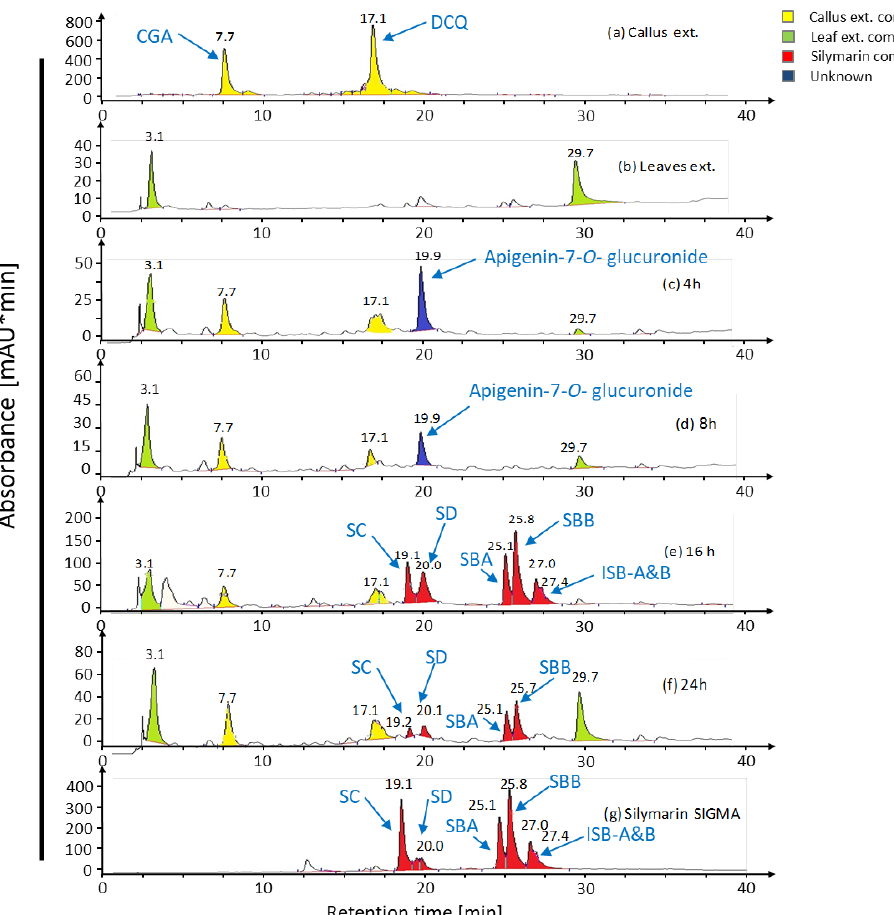
Figure 2. Chromatographic analysis of the products obtained from bioconversion. HPLC separations show the successive bioconversion of ( a ) callus compounds to silymarin derivatives using S. marianum leaf discs ( b ) and callus extract for 4 h ( c ), 8 h ( d ), 16 h ( e ), and 24 h ( f ). The conversion profiles are compared with standard silymarin SIGMA ( g ). Data obtained derive from six independent experiments.